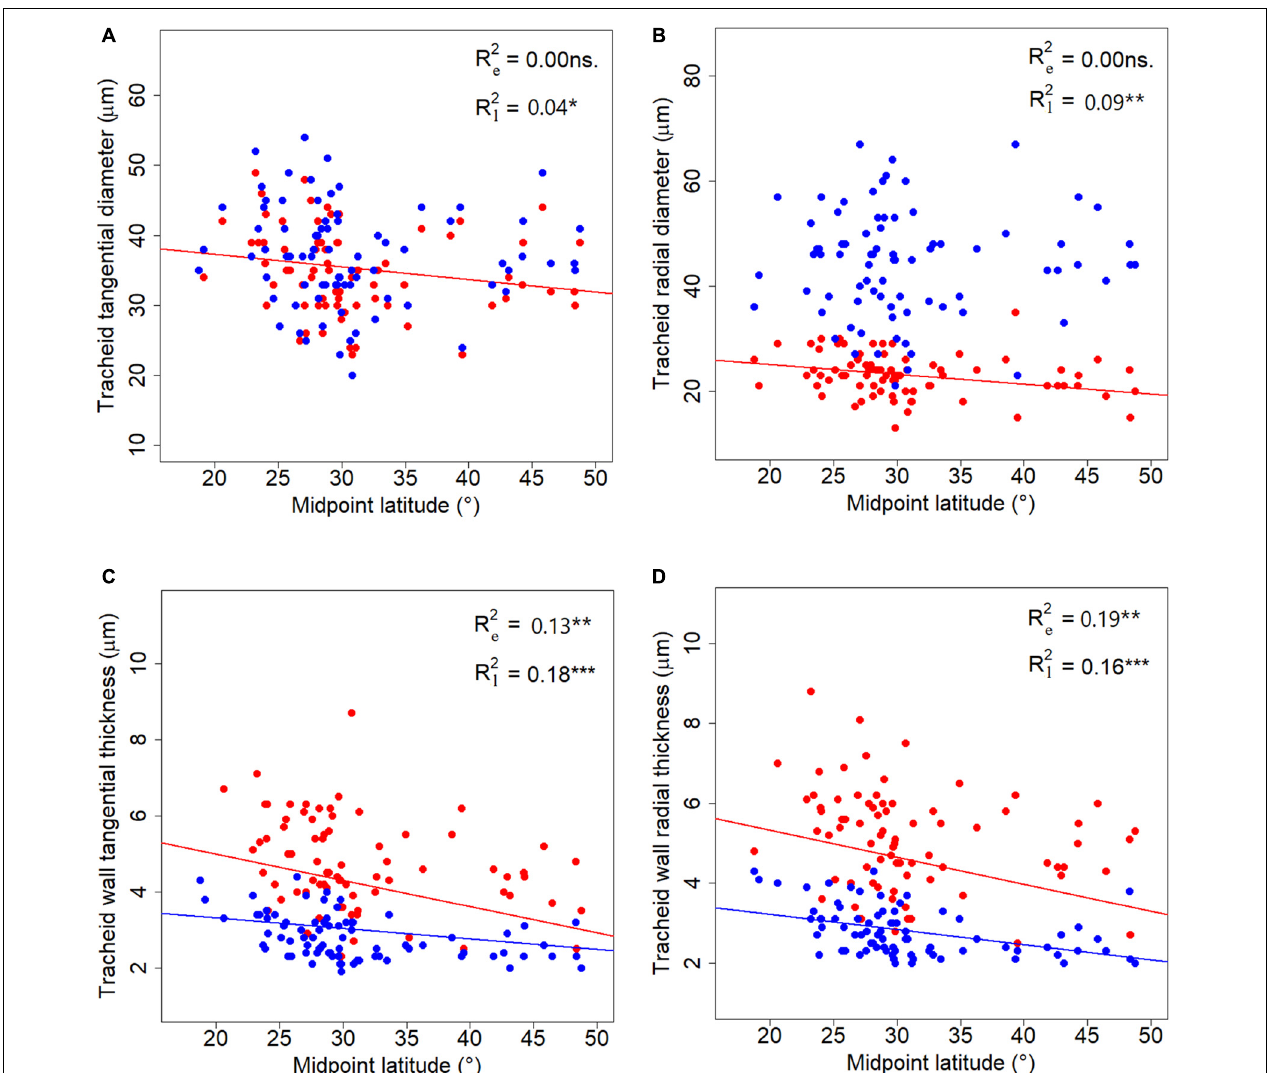
FIGURE 5 | Latitudinal trends of tracheid traits. (A–D) Represent latitudinal trends for the four tracheid traits studied respectively. Blue and red lines stand for fitted GPLS models for earlywood and latewood data, respectively. R 2 stands for the explanatory power of the latitude alone in the PGLS models, subscript “e” in R 2 stands for earlywood, while “l” stands for latewood. “*”, “**”, and “***” represent significance at level of 0.05, 0.01, and 0.001 respectively.